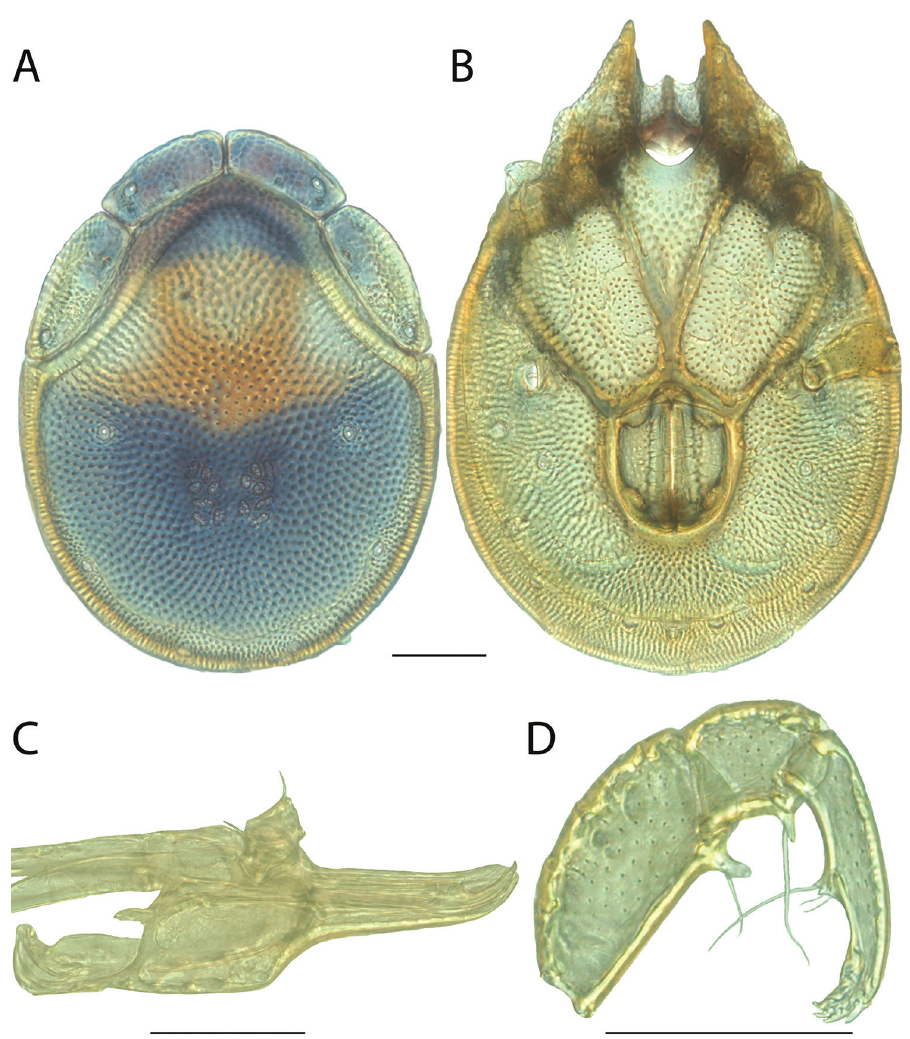
Figure 104. Torrenticola irapalpa sp. n. male: A dorsal plates B venter (legs removed) C subcapitulum D pedipalp (setae not accurately depicted). Scale = 100 µm. I mmatures